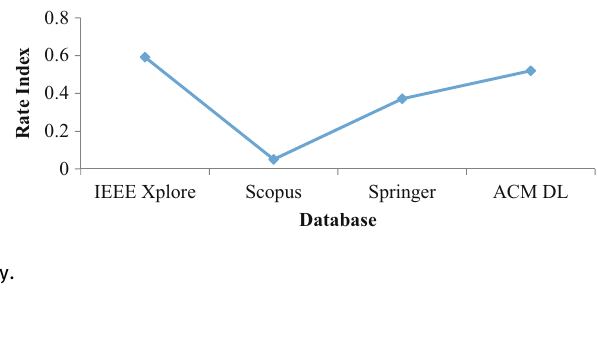
Figure 9: Rate index of